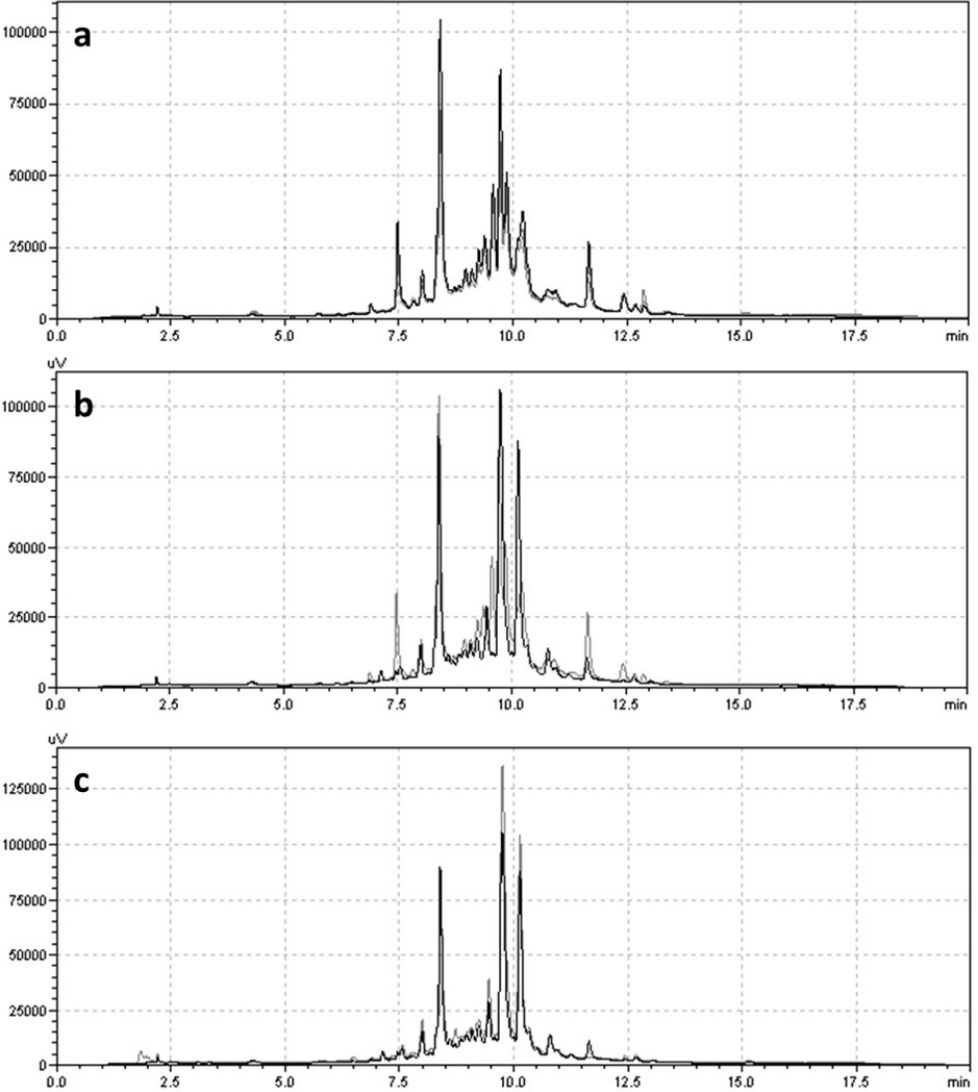
Figure 4. Comparison of chromatograms in wavelength 310 nm: (a) Overlap of chromatograms of infusions of anise samples (DH, DE, DL) in different commercial forms (spice, bulk and sachet); (b) Overlapping of the infusion chromatograms of samples DN (black) and DH (gray); (c) Overlapping of the infusion chromatograms of samples DN (black) and fennel